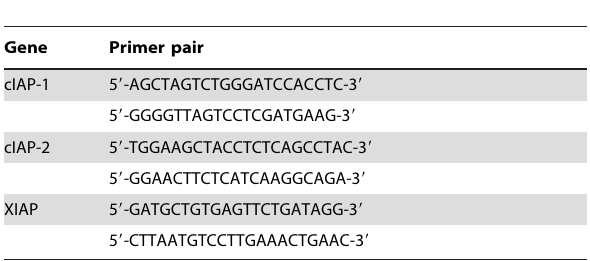
Table 1. Sequences for real-time PCR